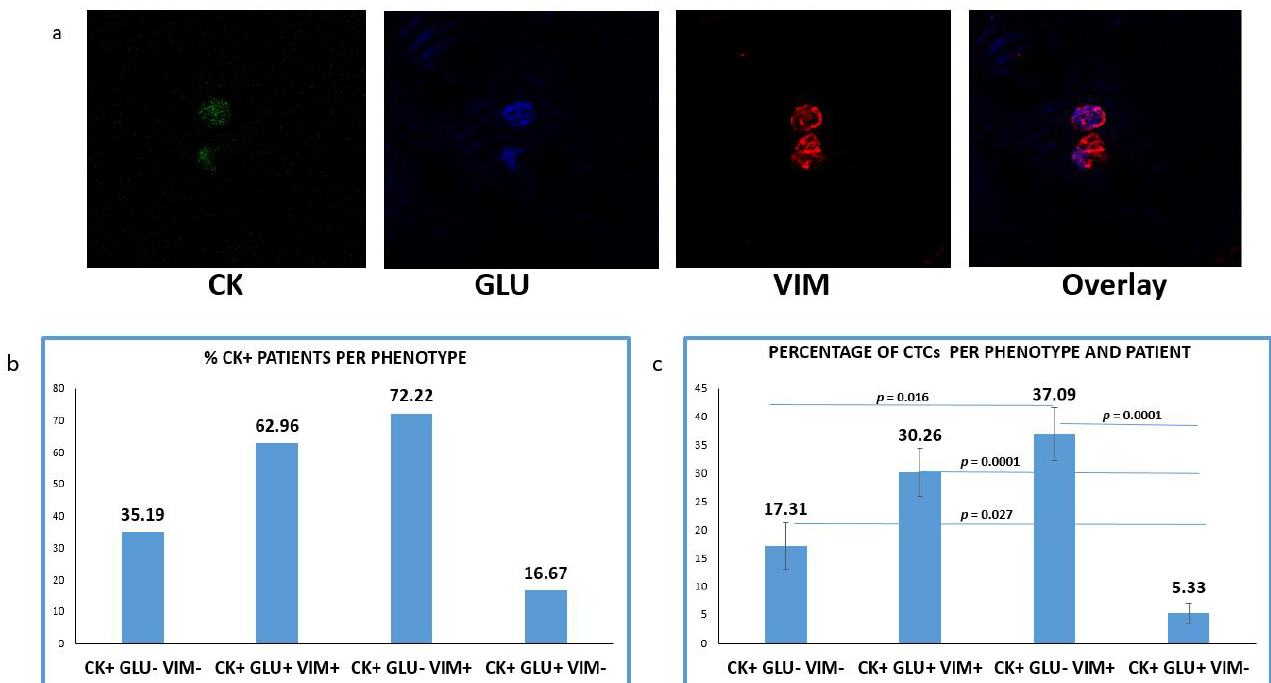
Figure 4. Expression of Cytokeratin (CK), Det yrosinated α - tubulin (GLU) and Vimentin (VIM) in patients’ CTCs. ( a ) Representative confocal laser scanning micrographs of patients’ CTCs ( ×40) stained for CK (green), VIM (red), GLU (blue) and DAPI (not shown because our confocal has no laser for DAPI); ( b ) Percentages of patients belonging to distinct phenotypes. Each patient was considered as positive for a distinct phenotype, if he/she’s harboring at le ast one CTC with this phenotype; ( c ) Percentage of CTCs per patient and per phenotype in the whole examined group of subjects.